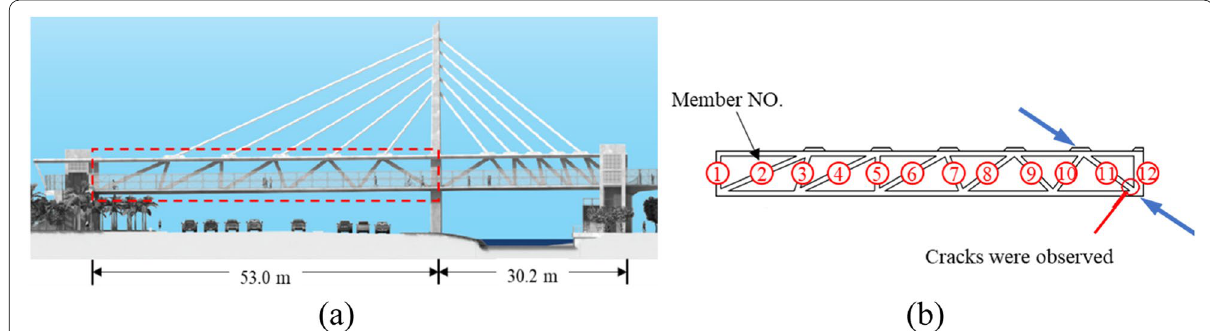
Fig. 5 Illustration of the bridge: a rendering of the bridge; and b the critical step causing bridge collapse: re-tensioning of the tendons in member 11. Cracks were observed at the joint between members 11 and 12 before the re-tensioning